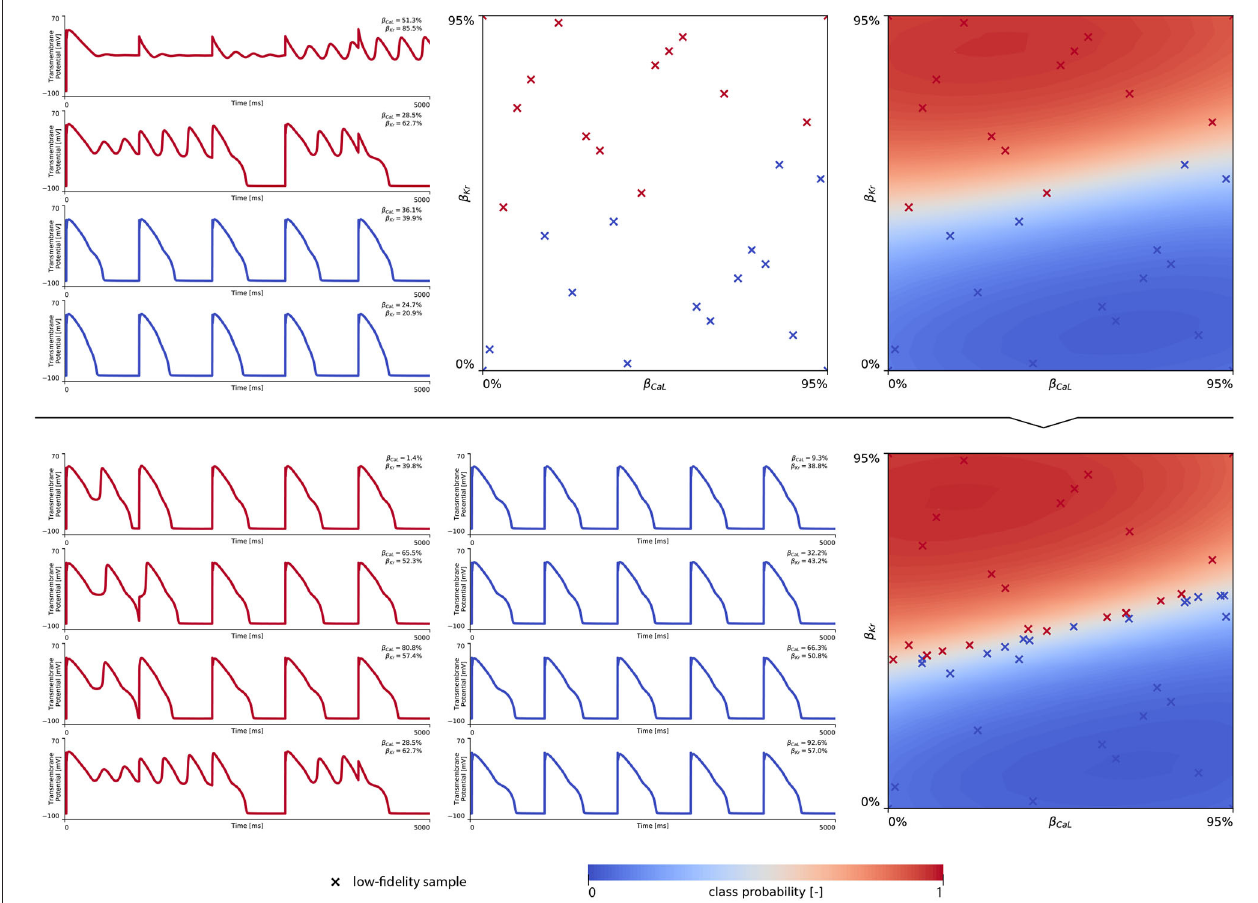
FIGURE A2 | Female single-fidelity drug-induced risk classifier. (Upper) Initial exploration of the drug-induced de- and repolarization abnormality risk parameter space. The first 25 internal latin hypercube samples of the B = { β Kr , β CaL } parameter space were evaluated for female midwall cell abnormalities, as showcased in the upper middle plot. Transmembrane potential evolution profiles of two normal and two early depolarizing samples are shown on the upper left plot. Using this exploratory B dataset, an initial single-fidelity drug-induced risk classifier was trained for the female midwall cell, see upper right subplot. (Lower) Exploration and exploitation of the drug-induced risk classification boundary using active learning. The Gaussian process classifier was trained further using 25 additional active learning { β Kr , β CaL } samples. On the lower left, four active learning sample evaluations resulting in abnormalities are shown. The lower middle plot showcases four active learning sample evaluations that showed normal action potentials. The final female cellular drug-induced risk classification boundary is shown in the lower right